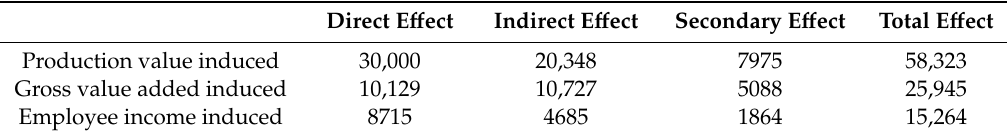
Table 4. The economic impact of constructing a timber check dam (unit is thousand yen).